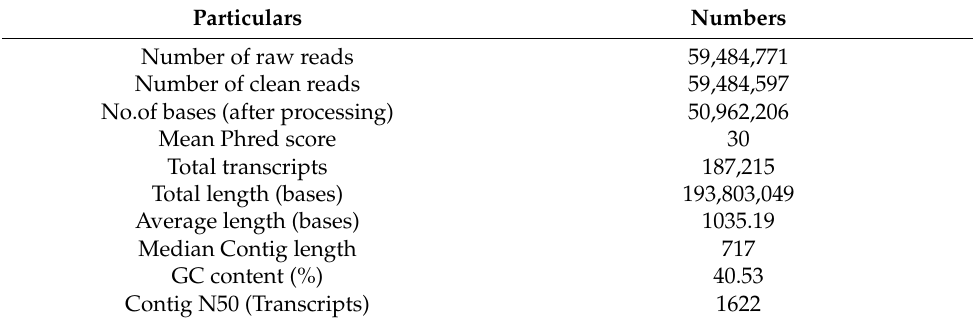
Table 1. Summary of Illumina paired-end sequencing and de novo assembly of Sida